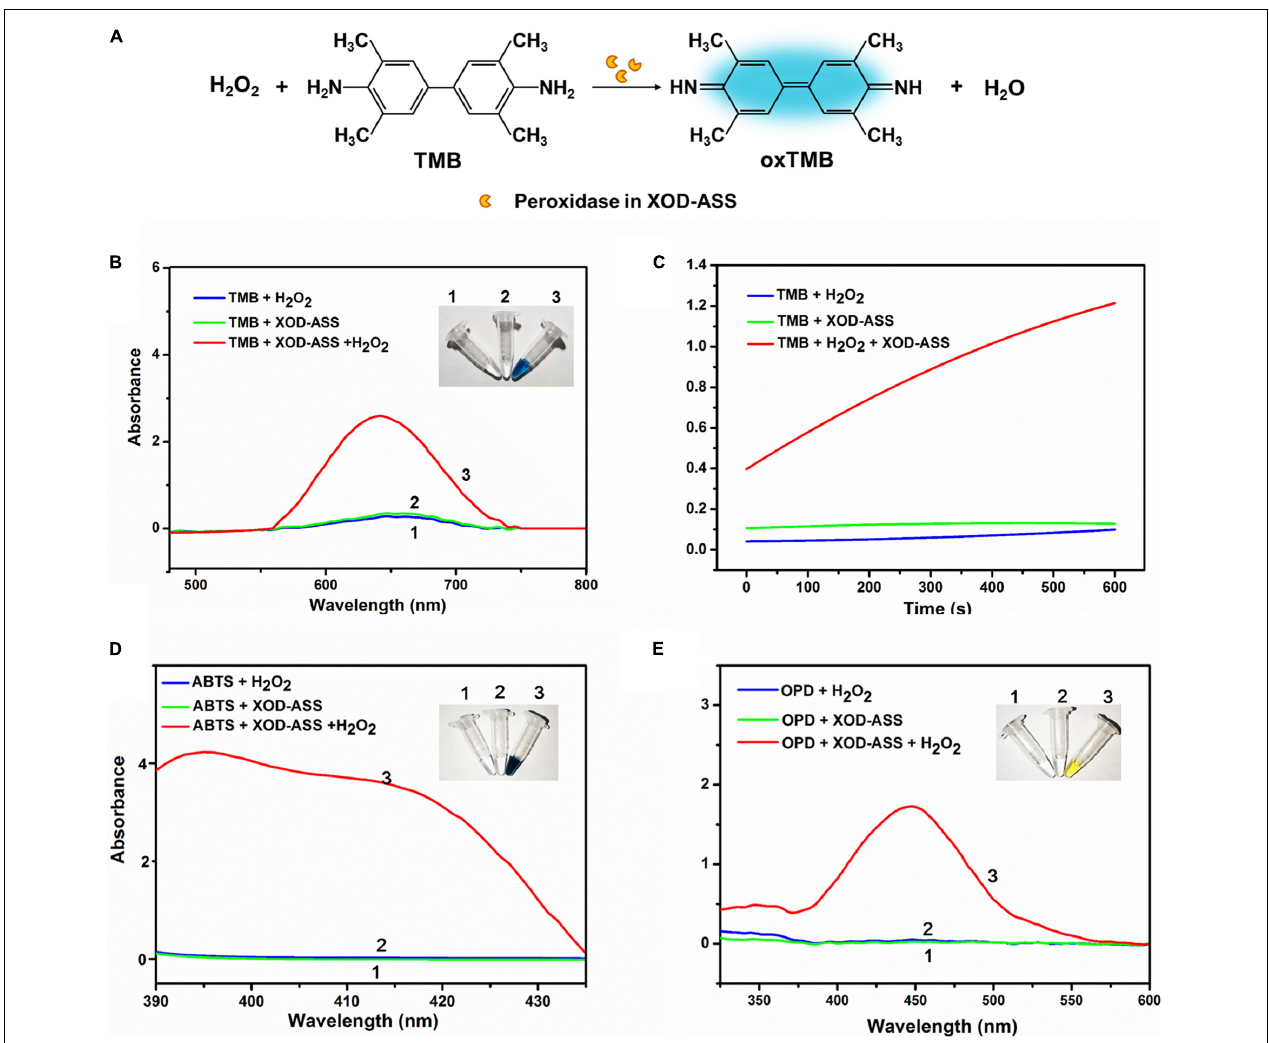
FIGURE 1 | XOD-ASS shows peroxidase activity. (A) Scheme illustration of oxidation of TMB into oxidized TMB by XOD-ASS. (B) The absorbance spectrum of XOD-ASS catalyzing the oxidation of TMB in the presence of H 2 O 2 . Inset represents the corresponding colorimetric result of the reactions. (C) The time-dependent absorbance curve at 652 nm of the reactions. (D) The absorbance spectrum of XOD-ASS catalyzing the oxidation of ABTS in the presence of H 2 O 2 . Inset represents the corresponding colorimetric result of the reactions. (E) The absorbance spectrum of XOD-ASS catalyzing the oxidation of OPD in the presence of H 2 O 2 . Inset represents the corresponding colorimetric result of the